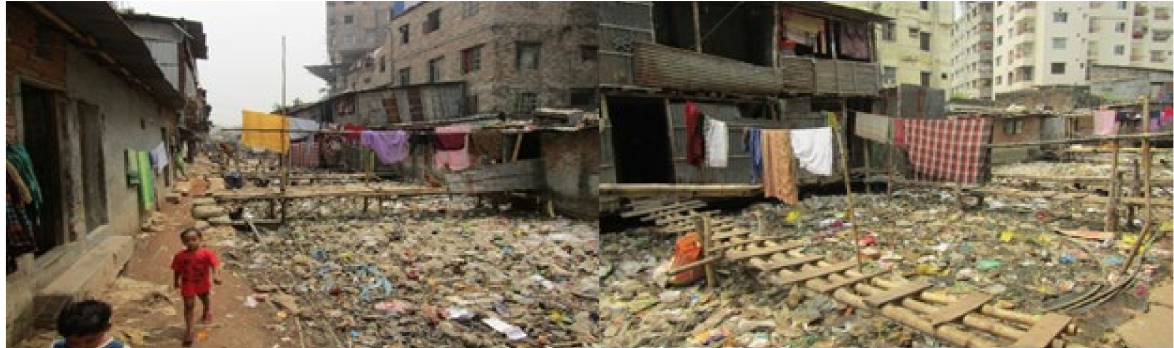
Figure 1. Mosaic ofsingle-use plastic creating thicklayers in anurban slum inDhaka city (Source: